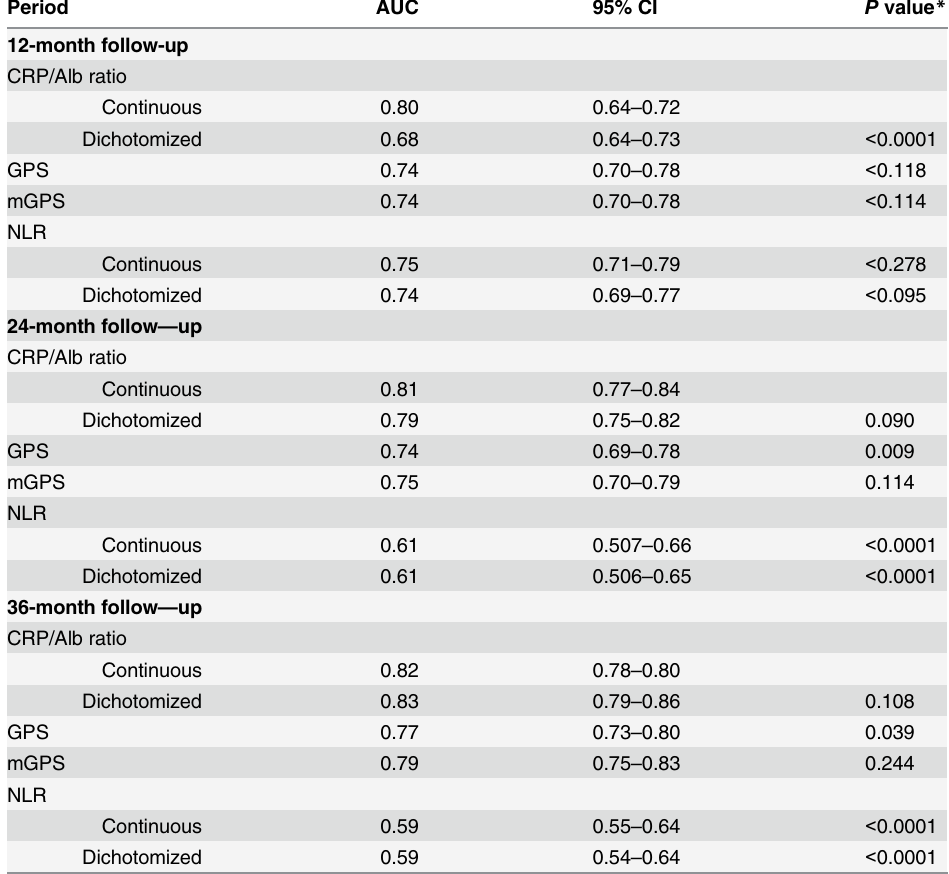
Table 2. Comparison of the areas under the curves for the four inflammation-based prognostic factors.